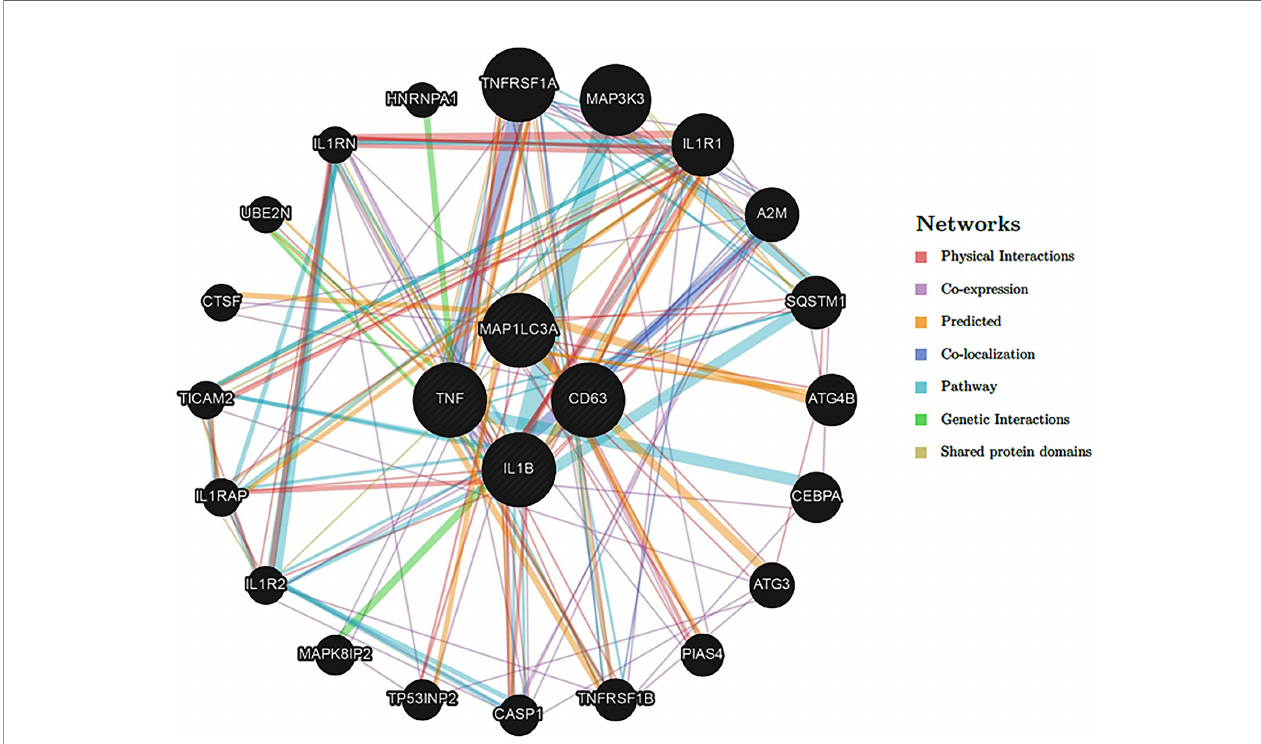
FIGURE 7 | Network analysis of autophagy and exosome genes. The possible interactions of the related genes were predicted using the GeneMANIA database